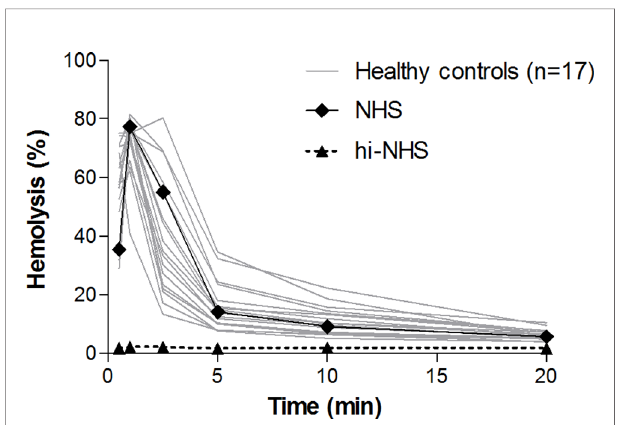
FIGURE 2 | Classical pathway convertase activity in healthy controls. Classical pathway convertase activity was measured by incubating sensitized sheep erythrocytes with sera obtained from 17 healthy individuals. Normal human serum (NHS) and heat-inactivated NHS (hi-NHS) were used as assay controls. Hemolysis levels are presented as percentage of full lysis of erythrocytes in water. Results represent means of at least three independent measurements for each sample. Standard deviations have been omitted for better